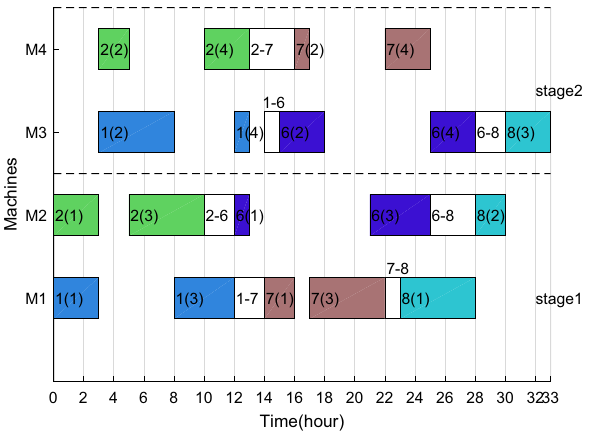
Figure 8. Factory1’s Gantt chart with ESRS.